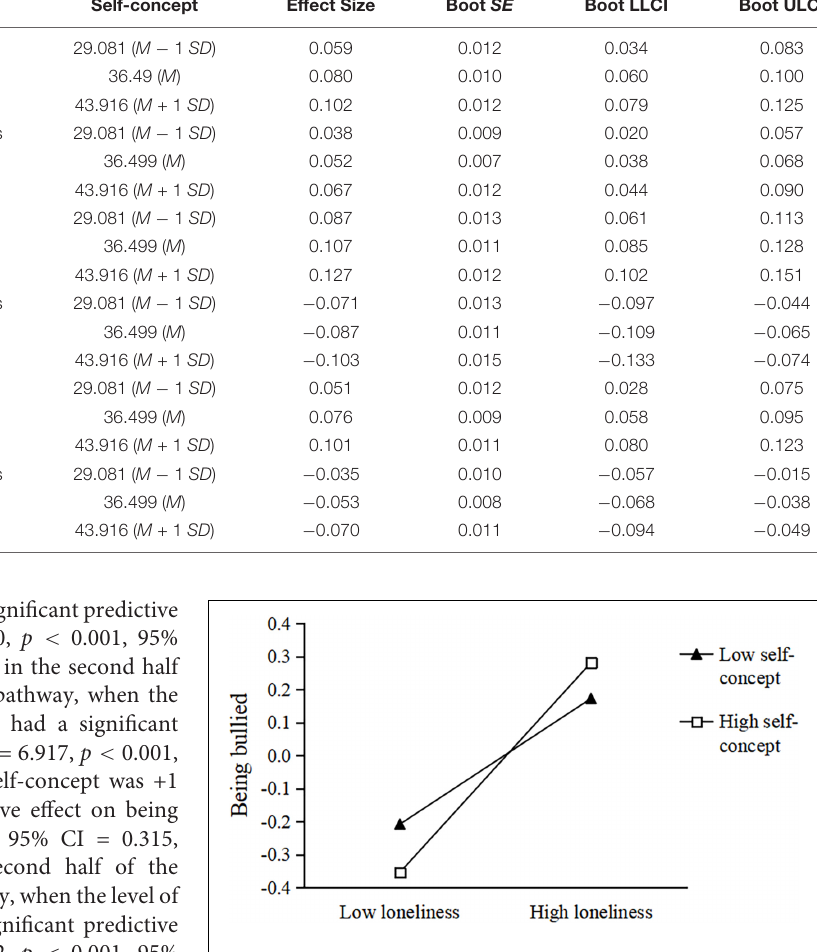
FIGURE 2 | The influence of loneliness on the relationship between being bullied and neuroticism: the moderated effect of self-concept. The black triangle represents low self-concept and the white square represents high